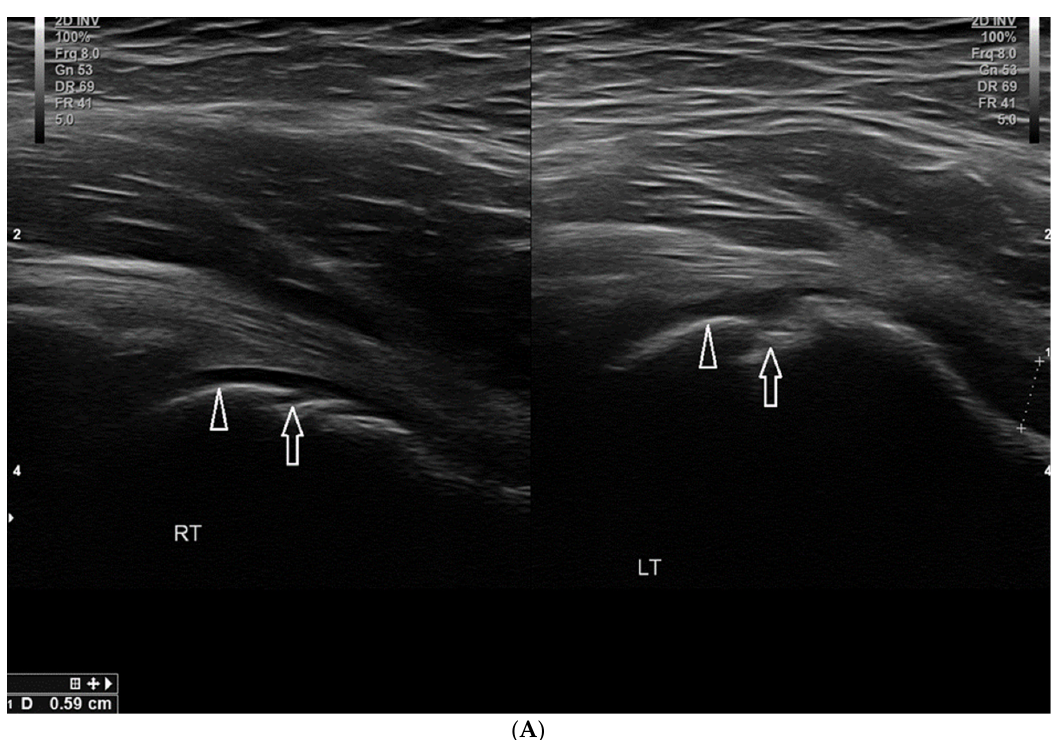
Figure 13. Image of the normal growth plates of the proximal end of the femur. Left arrow—growth plate of the femoral head (probe positioned along the long axis of the femoral neck); right arrow— growth plate of the greater trochanter (long axis view in the frontal plane). Linear probe 3–12 MHz.